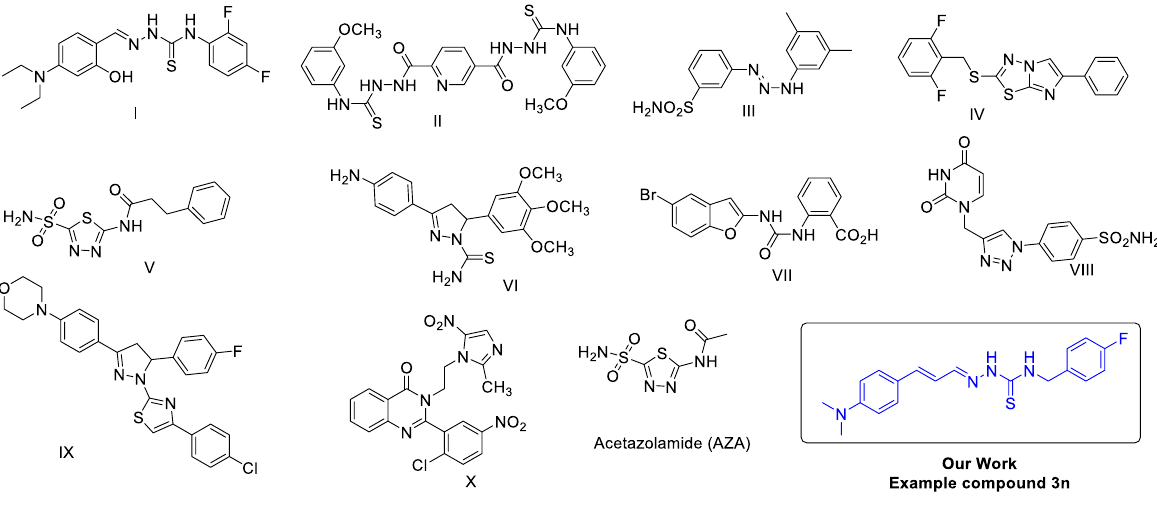
Figure 1. Examples of some known CA-II inhibitors with rational design of current work 29,59–67